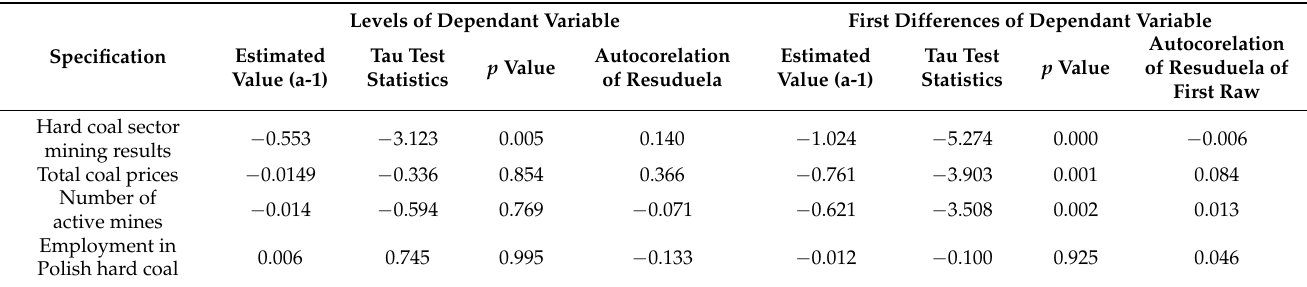
Table 2. Augmented Dickey–Fuller test (ADF